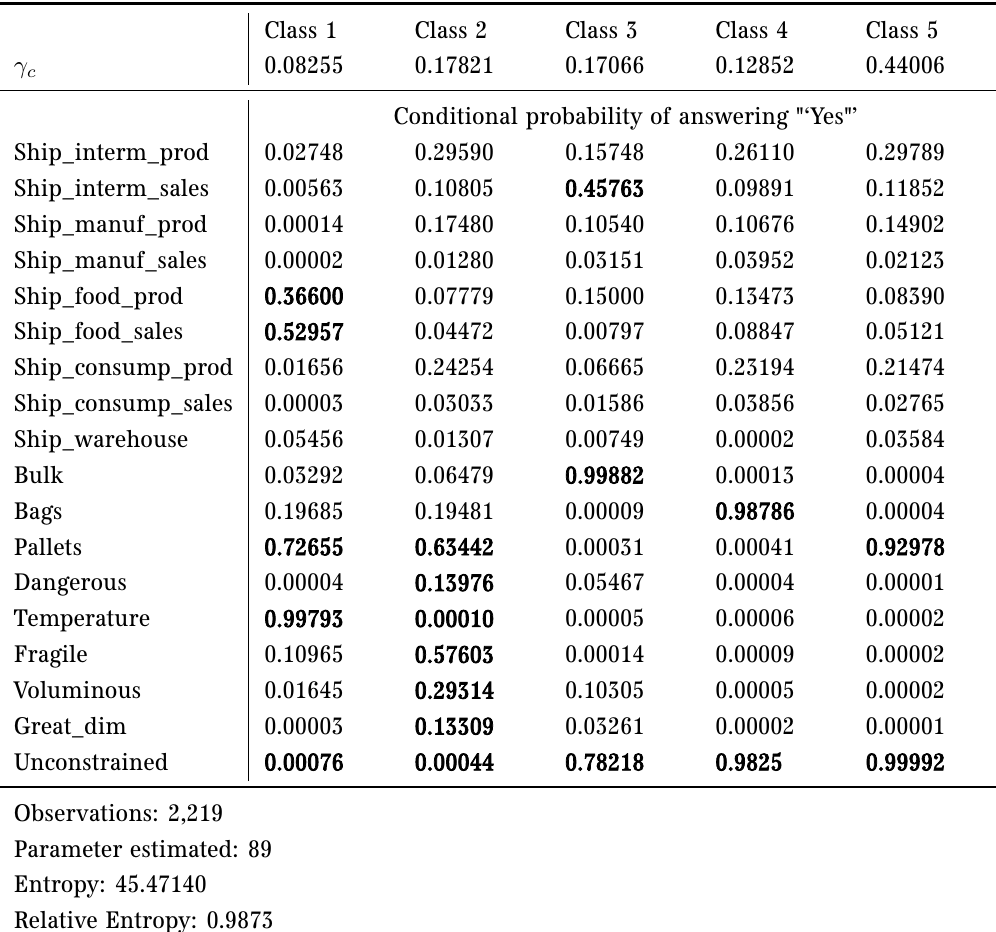
Table 6: LCA results for the preferred 5